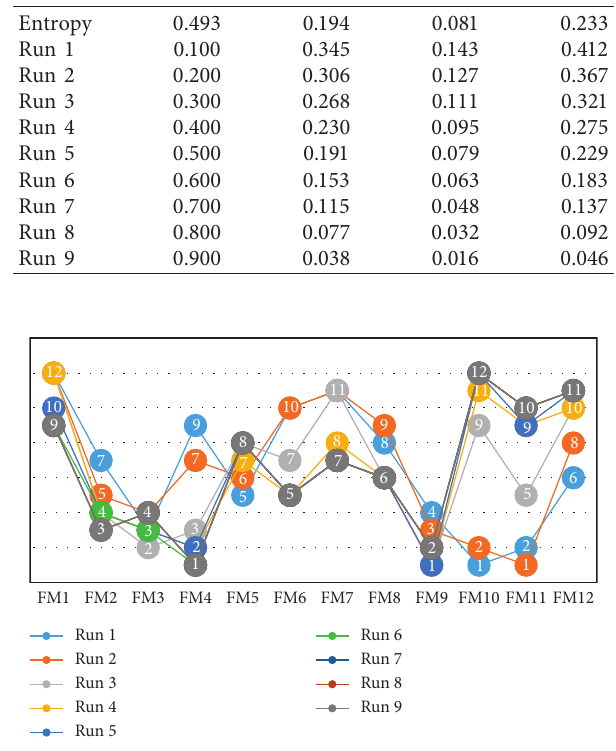
Figure 2: The ranking result of the failure mode after nine runs of the sensitivity